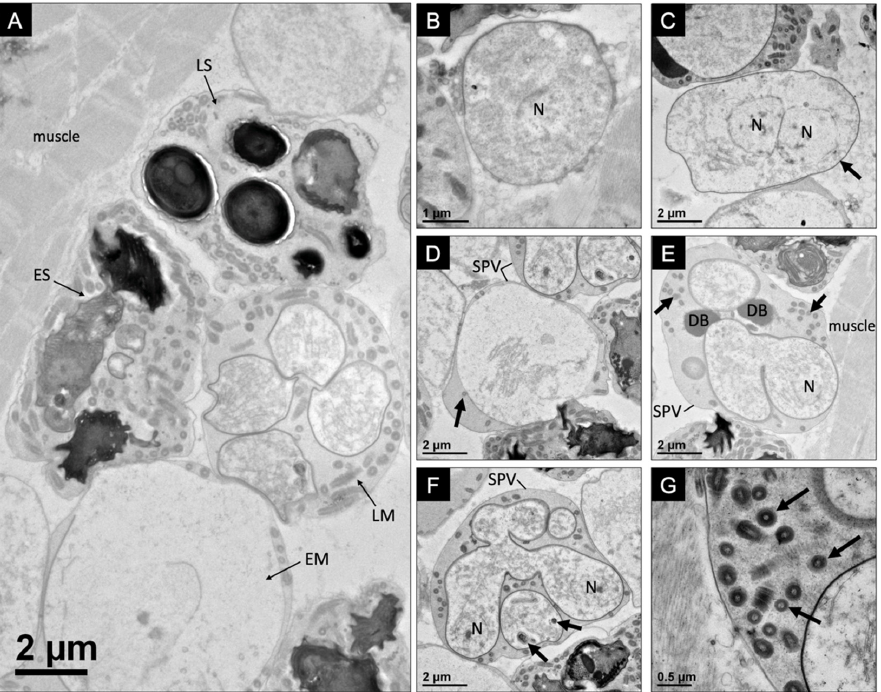
Figure 2. Merogony of Astathelohania virili n. sp. ( A ) This image identifies an early merogonal stage (EM), a late merogonal stage (LM), an early sporoblast stage (ES), and a late sporoblast stage (LS). Each stage is developing within their own sporophorous vesicle in close proximity to one another and near host muscle tissue; ( B ) a binucleate meront (N = nucleus) with a thin cell wall; ( C ) a binucleate meront (N = nuclei) with a thickening cell wall (arrow); ( D ) sporophorous vesicle (SPV) developing from meront with tubular-like structures present (arrow); ( E ) division of sporont into sporoblasts within SPV with one visible nucleus (N). SPV contains dense bodies (DB) and tubular-like structures (arrows); ( F ) another dividing sporont within an SPV. Electron-dense organelles beginning to develop within developing sporonts (arrows); ( G ) high magnification image of tubular-like structures (arrows) found within late merogony SPVs.